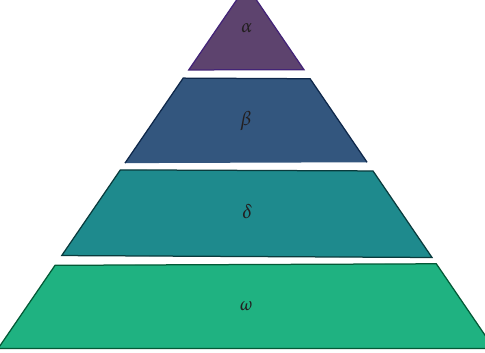
Figure 7: GWO pyramid